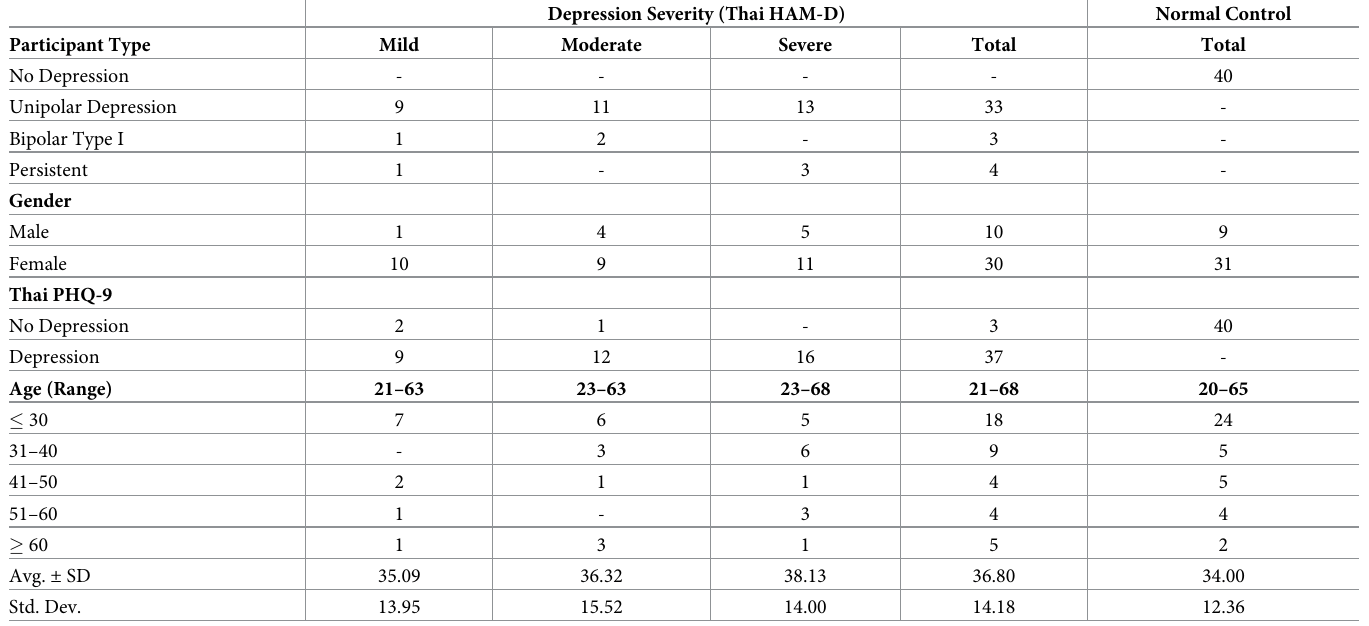
Table 2. Participants’ demographic